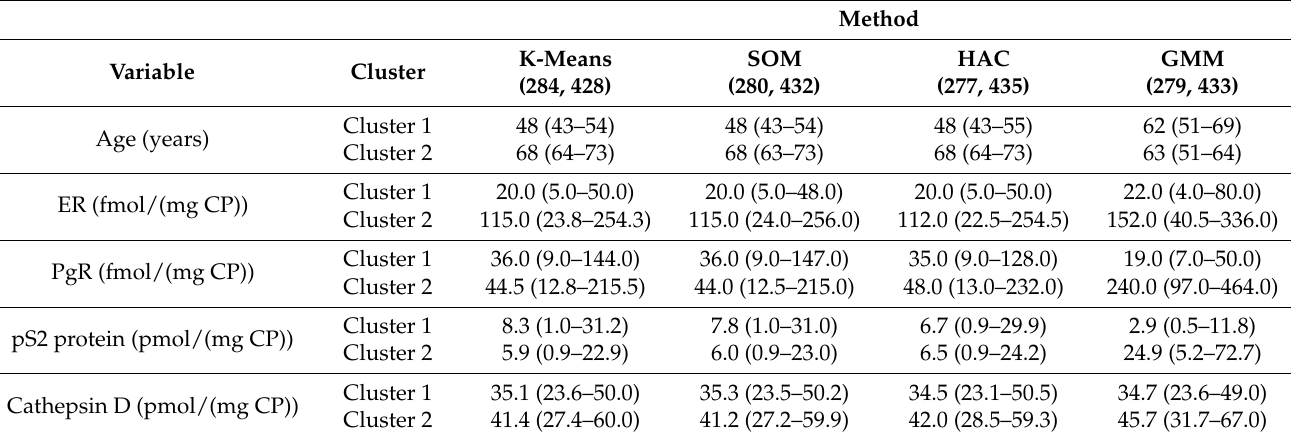
Table 4. Distributions of the variables in the two clusters obtained with the four algorithms (size of cluster 1, size of cluster 2). Variables are represented with median values (1st quartile–3rd quartile).